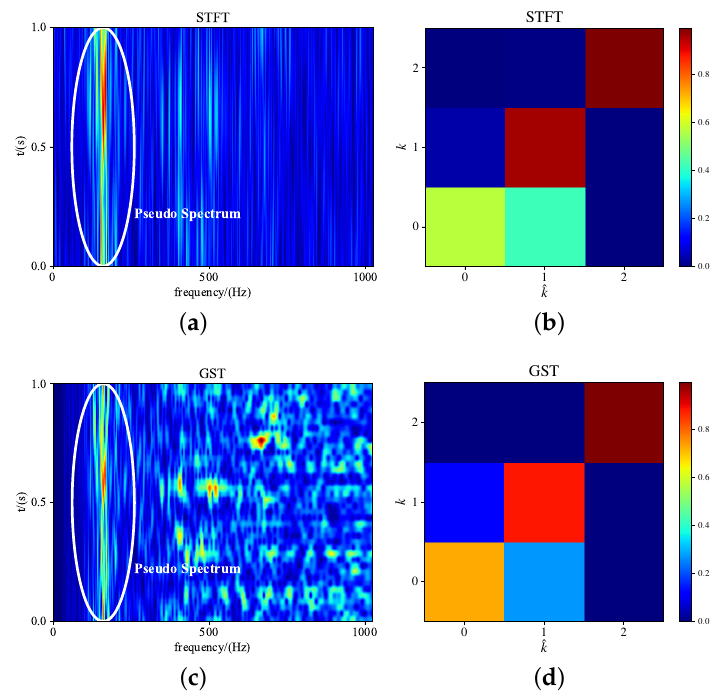
Figure 12. Confusion between spectral lines and electrical noises-induced pseudo-lines. ( a , c ) cor- respond to the STFT and GST feature of background noise (target absent); ( b , d ) give the confusion matrix of STFT and